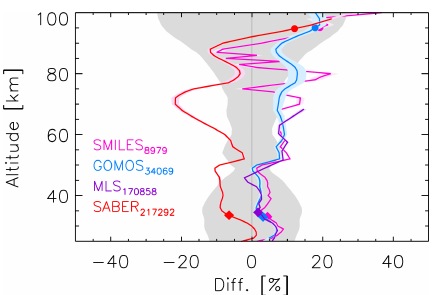
Figure 9. Global mean (for all latitudes and seasons) of the daytime O 3 VMR differences (MIPAS–instrument) in percent of MIPAS be- tween co-located pairs of measurements of MIPAS (MA mode) with ACE-FTS (green), SABER (red), MLS (purple), and SMILES (ma- genta). For more details, see caption of Fig. 7.